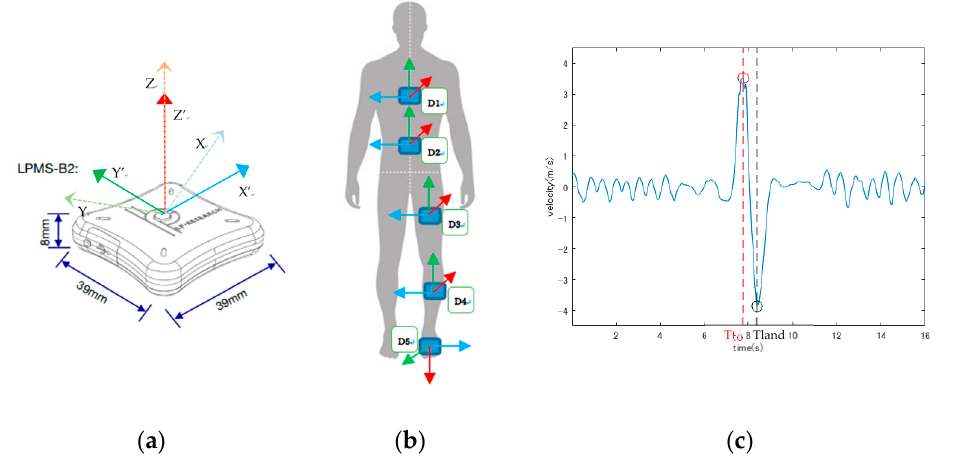
Figure 1. Key stages in data collection and processing procedure. ( a ) Sensor coordinate system S (X’Y’Z’) was aligned with the global coordinate system G (XYZ) automatically. Only the Z’-axis